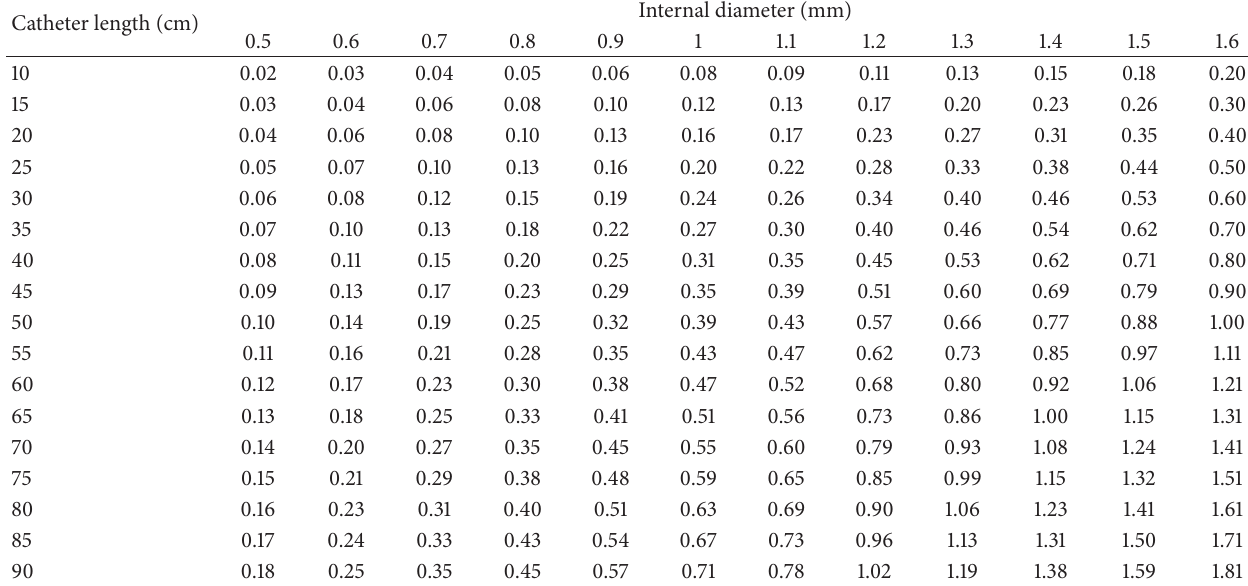
Table 2: Internal volume of single lumen venous catheters in